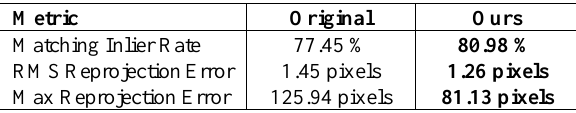
Table 1. Metric of bundle adjustment. (f) Ours